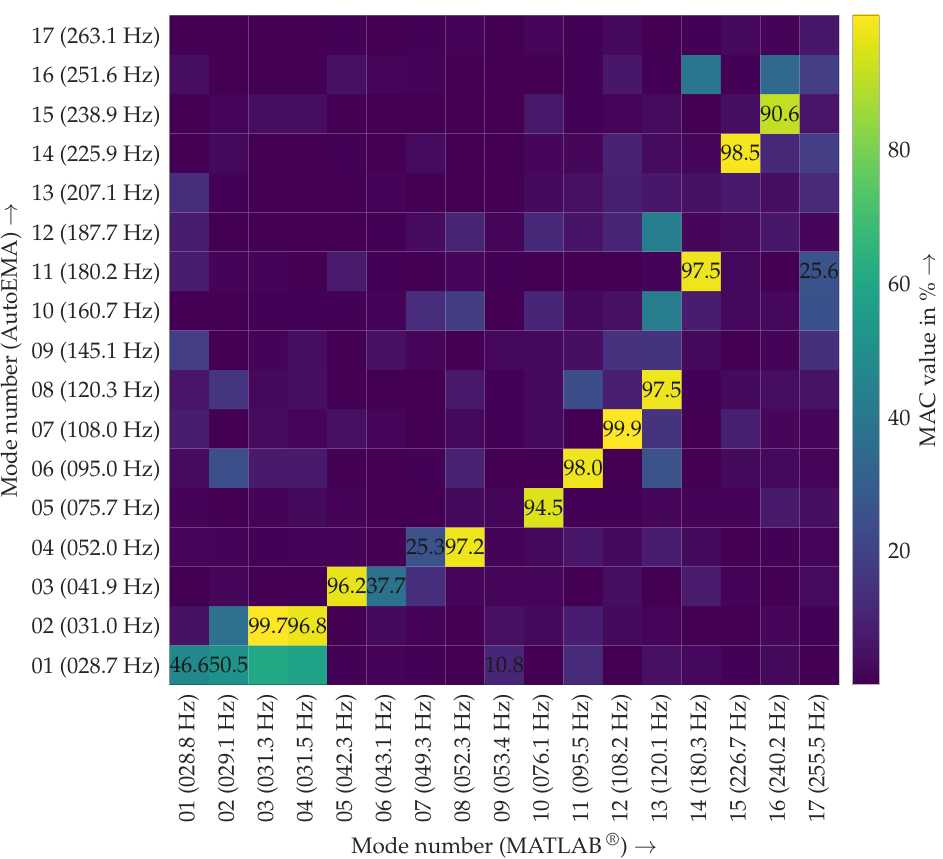
Figure 8. Correlation between the modes up to 300Hz found by the AutoEMA approach and MATLAB ® modalfit determined by the MAC for the WPT position z 2